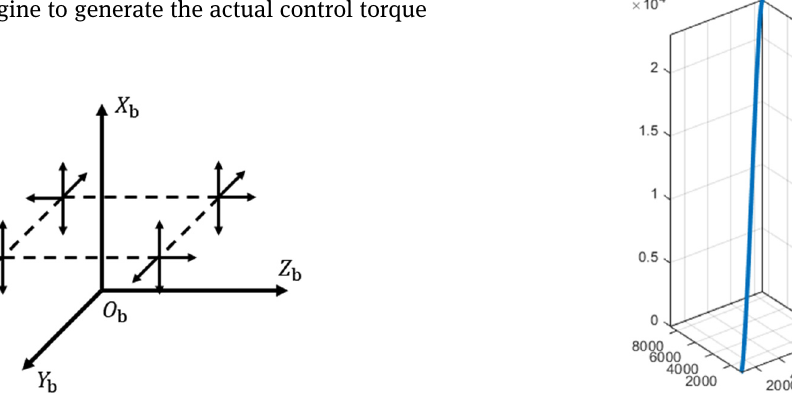
Figure 4: Con fi guration mode of attitude control engine.